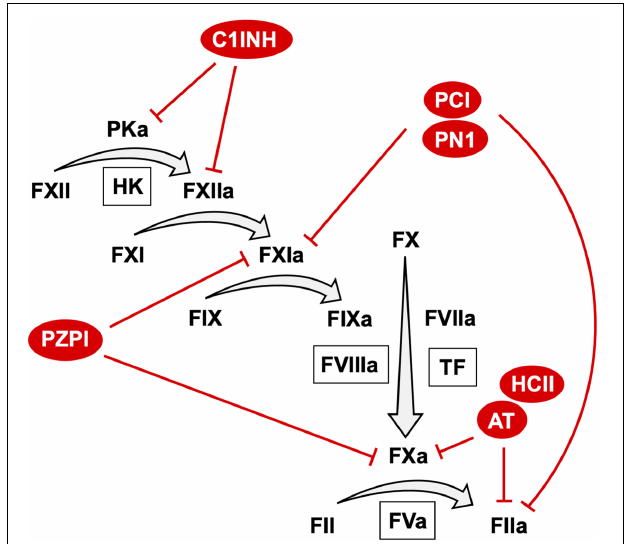
FIGURE 1 | The coagulation cascade and anticoagulant SERPIN targets. A schematic representation of the coagulation cascade annotated with anticoagulant SEPRIN targets. For clarity only the top targets of each SERPIN with second order inhibitory rate constants > 1.0 × 10 5 are represented. A comprehensive list of targets and second order inhibitory rate constants is provided in Table 1